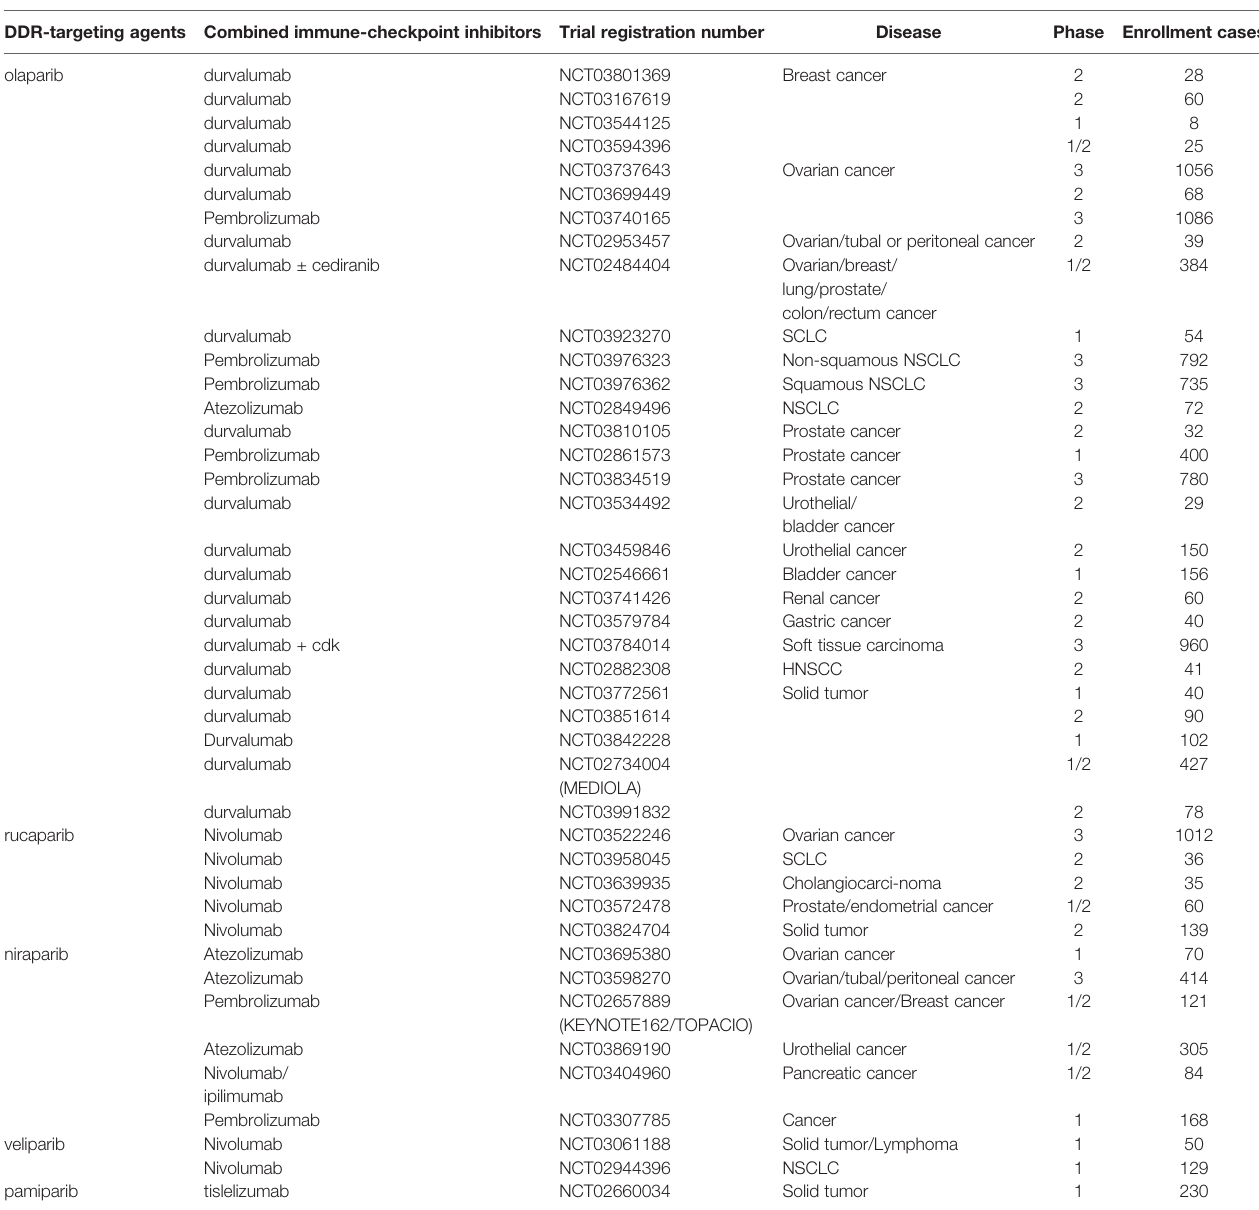
TABLE 1 | Clinical trials combining PARP inhibitors with immune checkpoint inhibitors. DDR-targeting agents Combined immune-checkpoint inhibitors Trial registration number